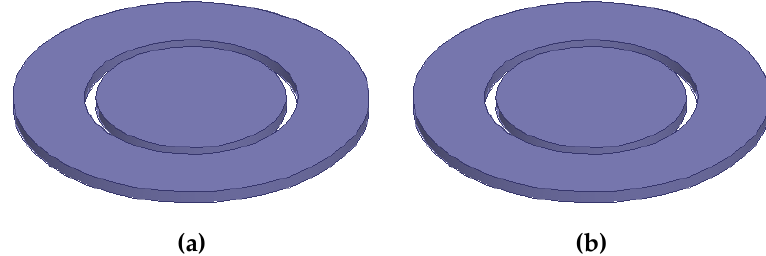
Figure 20. Optimized core in a circular coupler: ( a ) Primary core; ( b ) Secondary core.